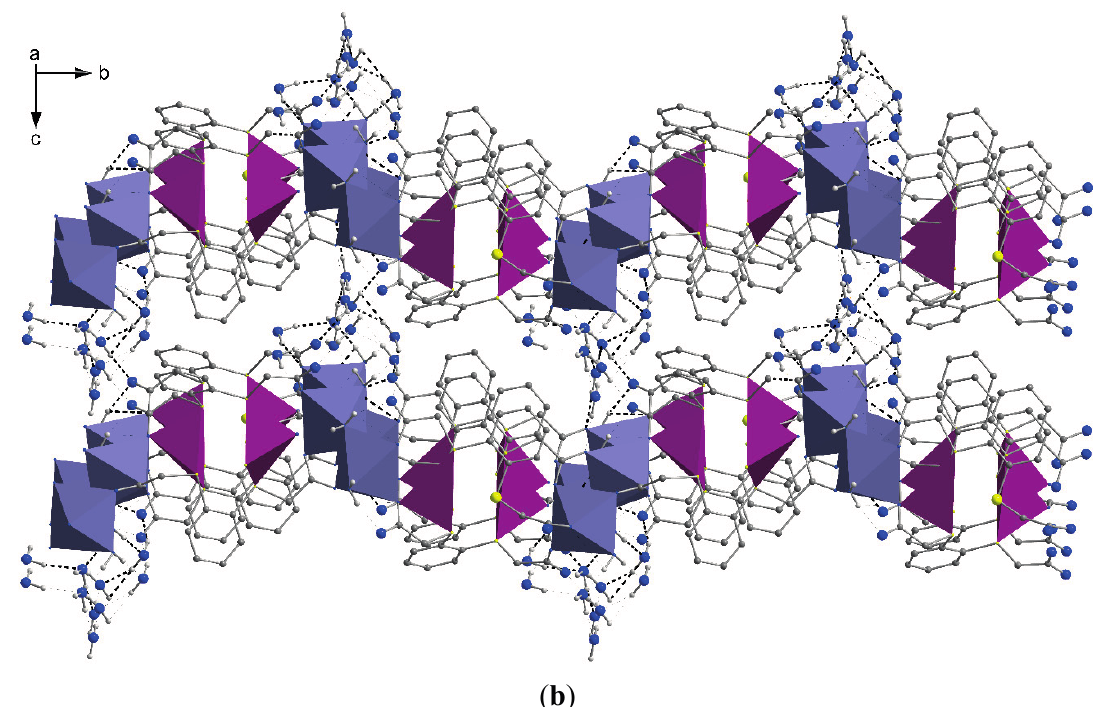
Figure 5. Three-dimensional hydrogen-bonded network of 2 (dashed lines) ( a ) with atom labeling and ( b ) with coordination polyhedra (blue-gray polyhedra denote the coordination environment of cadmium ions, and violet polyhedra the coordination environment of the silver